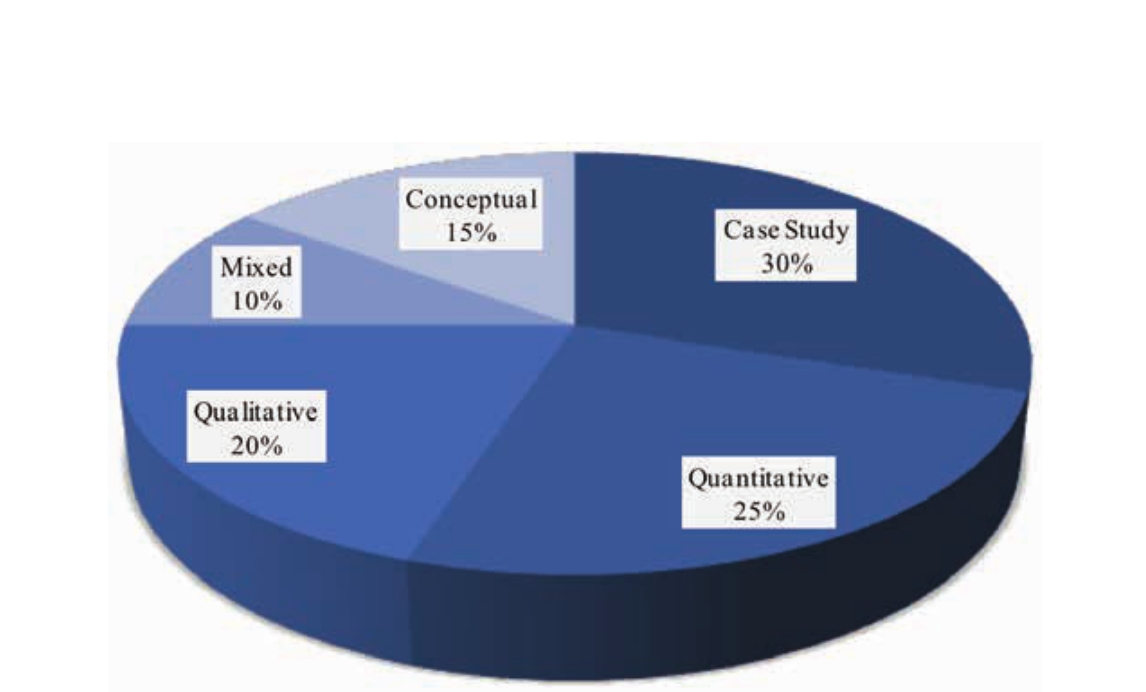
Figure 4. Research Methods in Organizational Culture and Knowledge